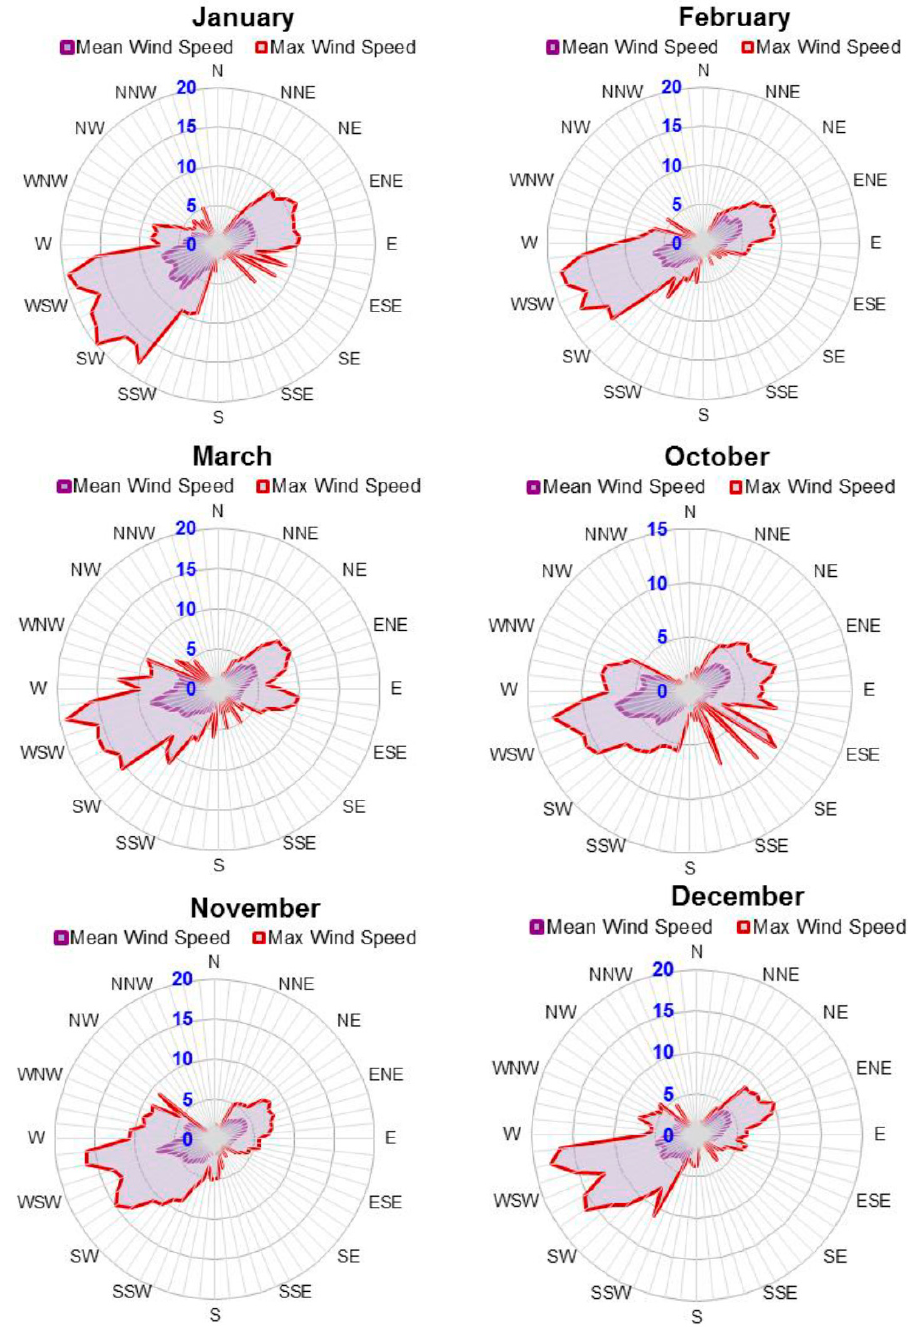
Figure 7. Mean and Max Wind Speed for selective months.